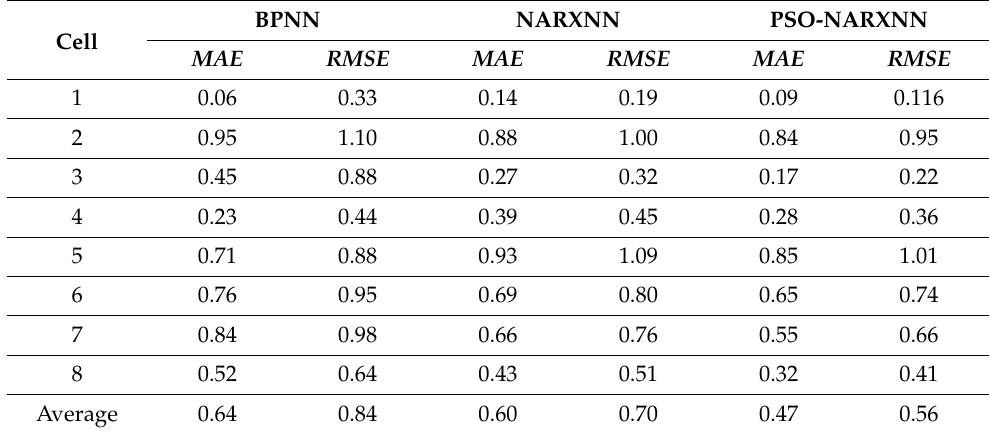
Table 4. Summary of MAE and RMSE of different algorithms. Cell